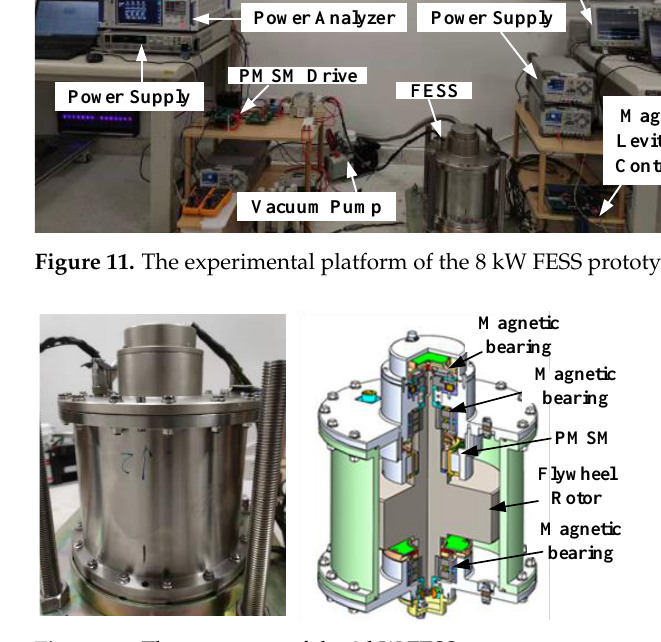
Figure 12. The prototype of the 8 kW FESS.